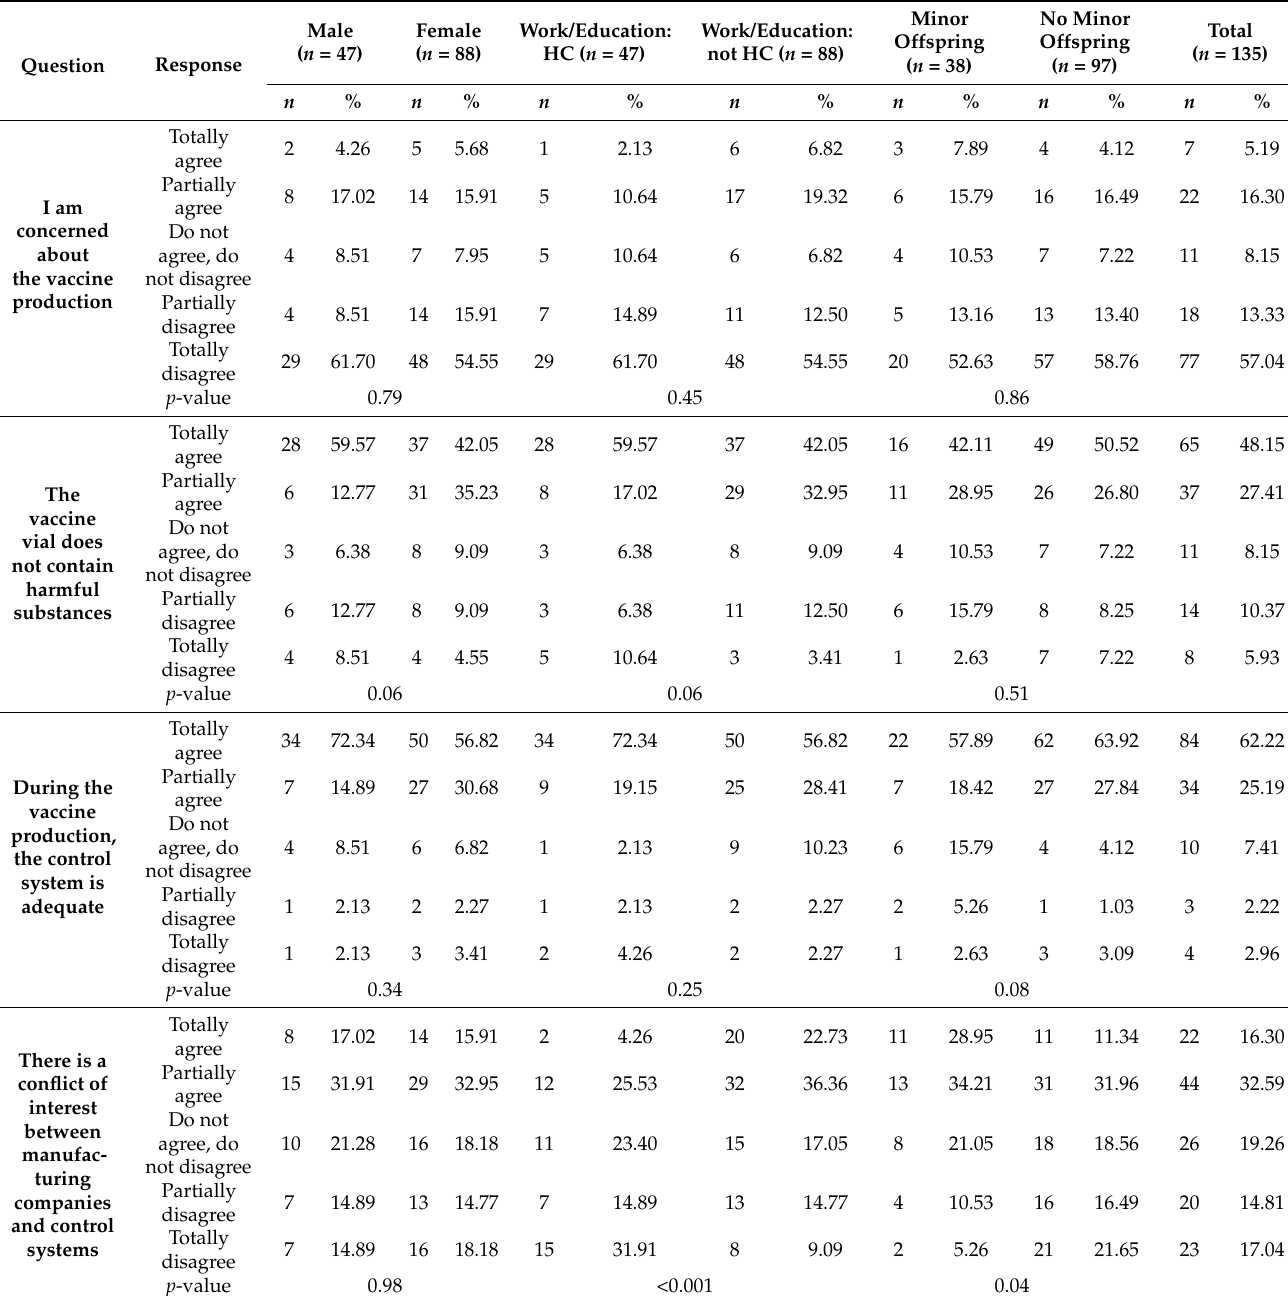
Table 2. Results of Section 2 of questionnaire: summary of the distribution of perceptions about vaccine production process stratified by sociodemographic characteristics. (Note—HC: